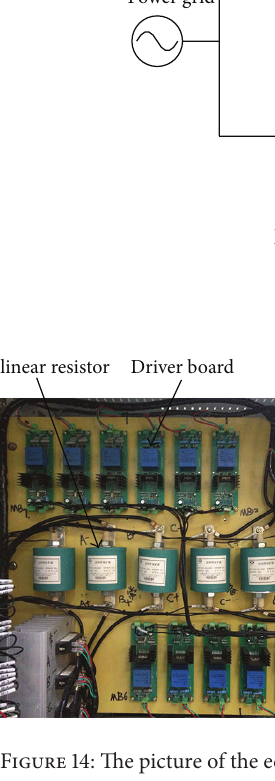
Figure 14: The picture of the equipment.